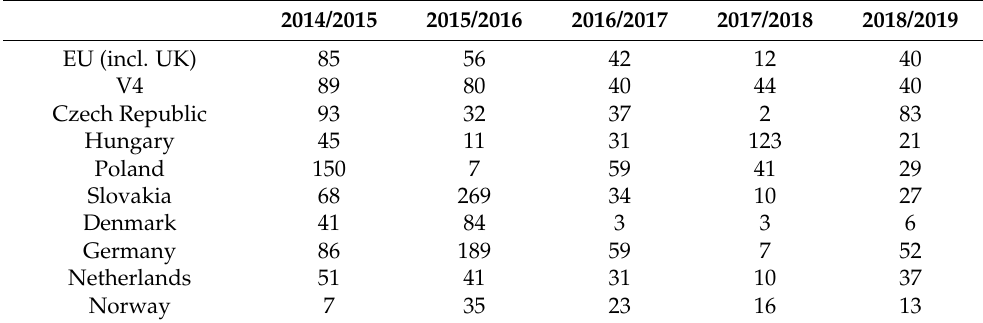
Table 4. The yearly growth of infrastructure in % at the turn of the years, (source: elaborated by authors based on [25]).